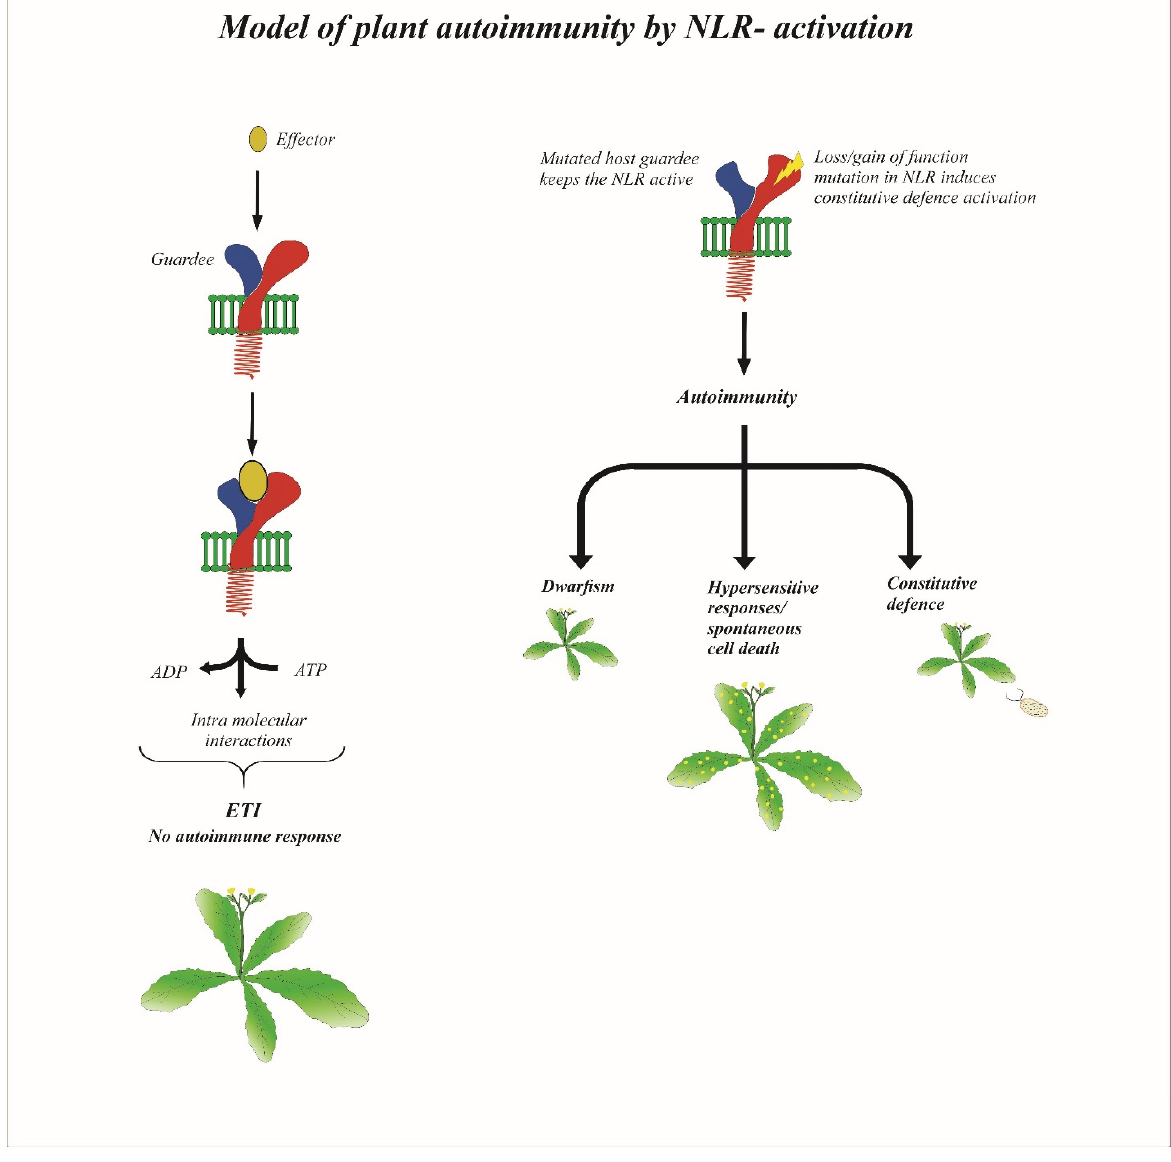
Figure 2. Model of plant autoimmunity by NLR-activation. Modification of guardee protein by the effector is perceived by NLR receptor thereby activating a strong immune response termed as effector-triggered immunity (ETI). Induced mutations/knockouts of host guardee or loss/gain of function mutations in NLR proteins initiates constitutive downstream defense signaling, resulting in autoimmunity characterized by dwarfism, hypersensitive responses, and increased defense against pathogens.